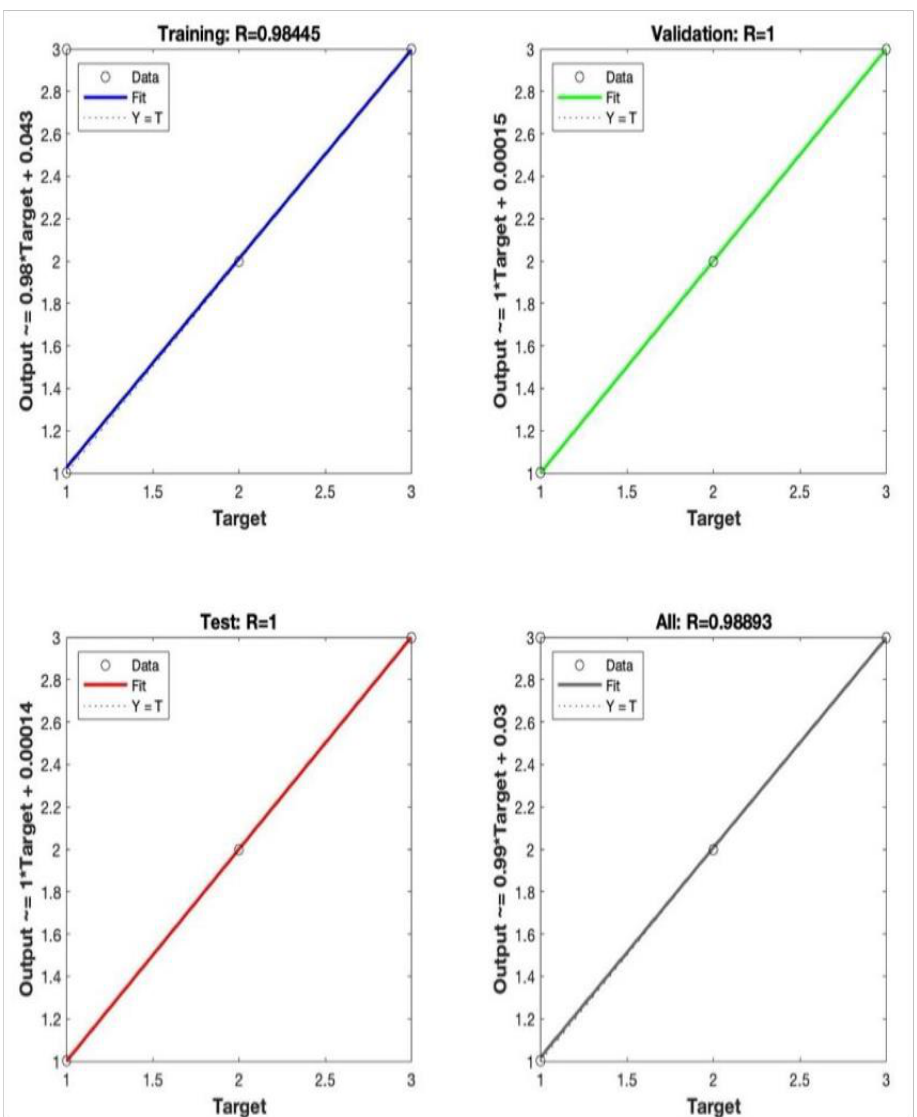
Figure 7: Regression plot of SubA_5chan_3LRF by RNN Classifier